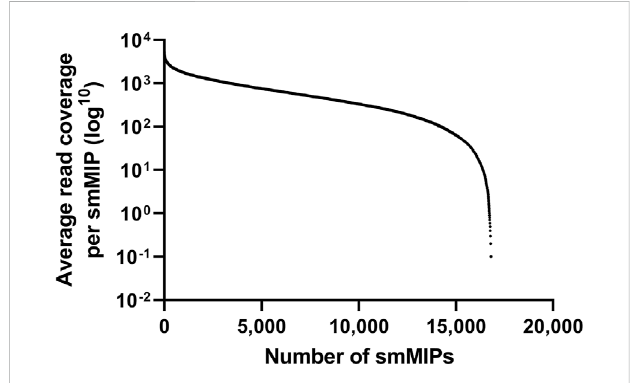
FIGURE 1 Average read coverage per smMIP in the RP-LCA